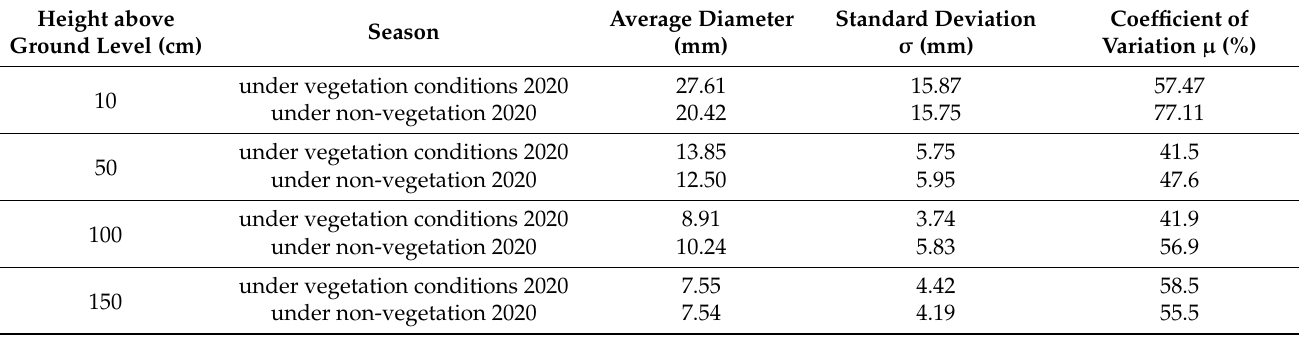
Table 2. Summary of the results of the series of measurements of the branch diameters of shrub No. 2.